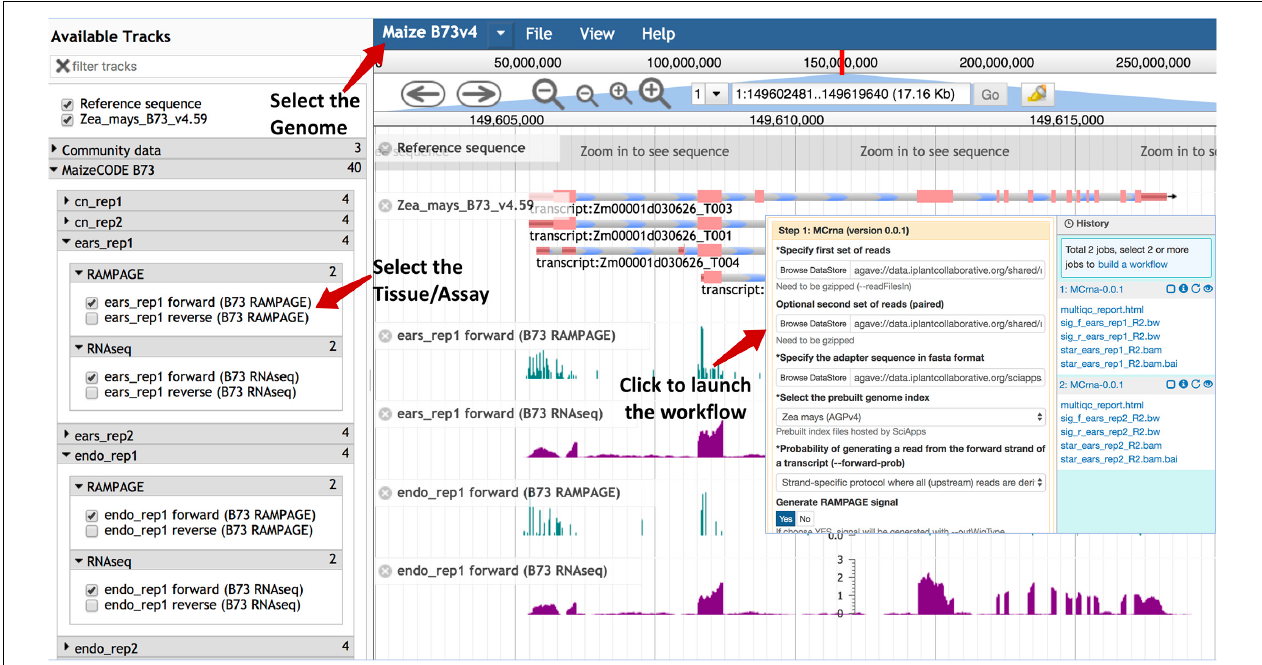
FIGURE 2 | Genome browser tracks for the MaizeCODE data. JBrowse is used to hold the MaizeCODE signal tracks, which are organized in the following order: genome, tissue, replicate, and assay. Clicking on each track brings up the workflow “Relaunch” interface.